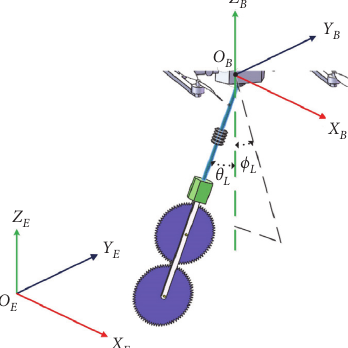
Figure 2: The suspended saws